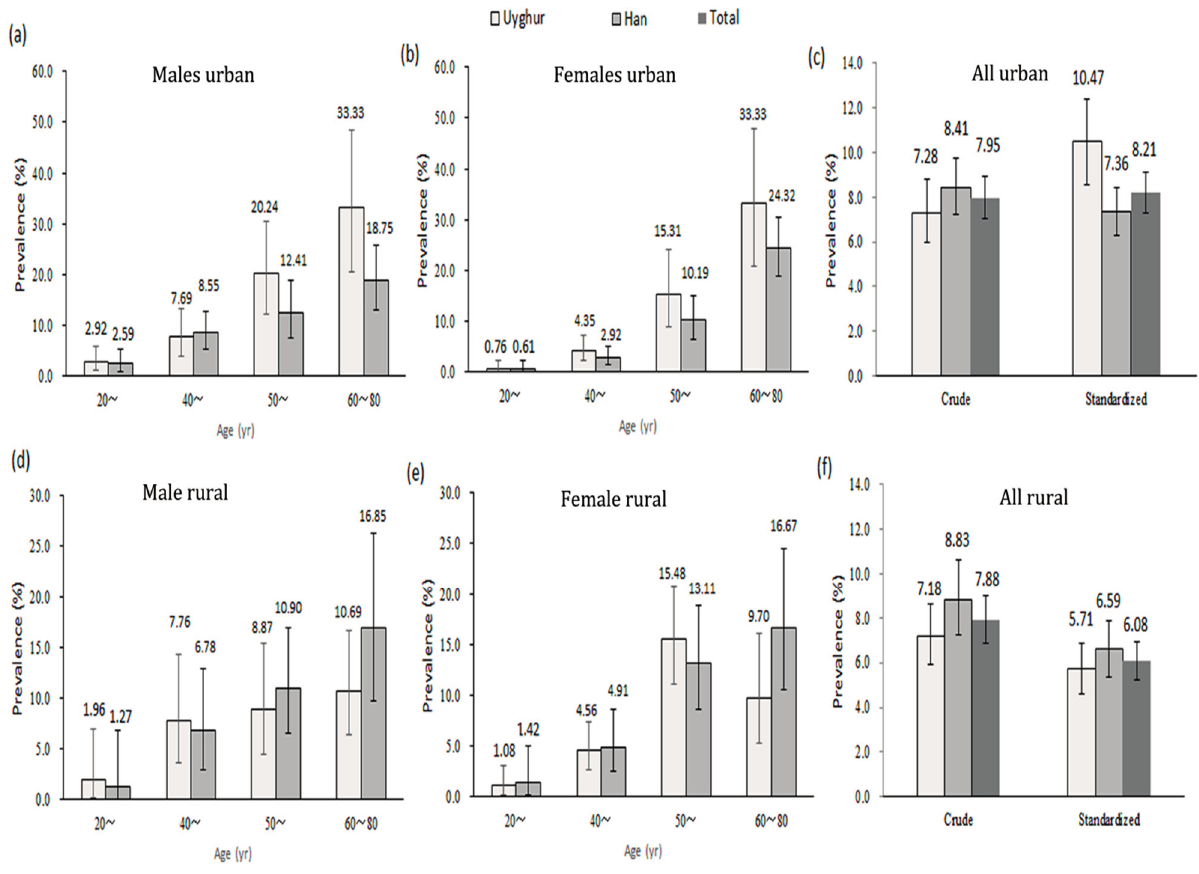
Figure 1. Age-specific prevalence of diabetes in Uyghur and Han populations. ( a ) The age-specific prevalence of diabetes in males in Uyghur and Han populations in urban areas; ( b ) The age-specific prevalence of diabetes in females in Uyghur and Han populations in urban areas; ( c ) The crude and age- and gender-standardized prevalence of diabetes in Uyghur and Han populations in urban areas; ( d ) The age-specific prevalence of diabetes in males in Uyghur and Han populations in rural areas; ( e ) The age-specific prevalence of diabetes in females in Uyghur and Han populations in rural areas; ( f ) The crude and age- and gender-standardized prevalence of diabetes in Uyghur and Han populations in rural